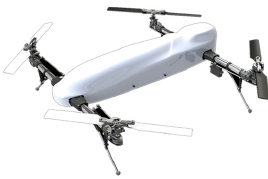
Figure 1. The variable-pitch quadrotor.